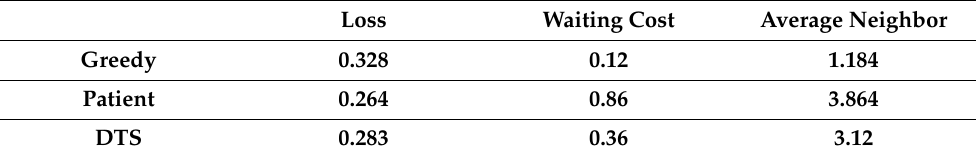
Table 2. The performance comparison among three different